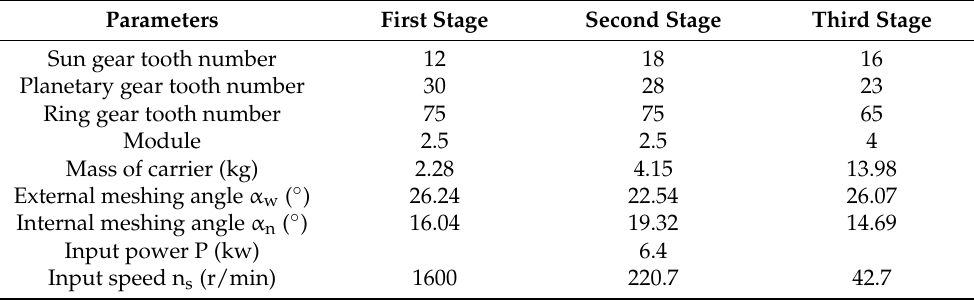
Table 2. Parameters of the pitch drive of a 2 MW wind turbine.